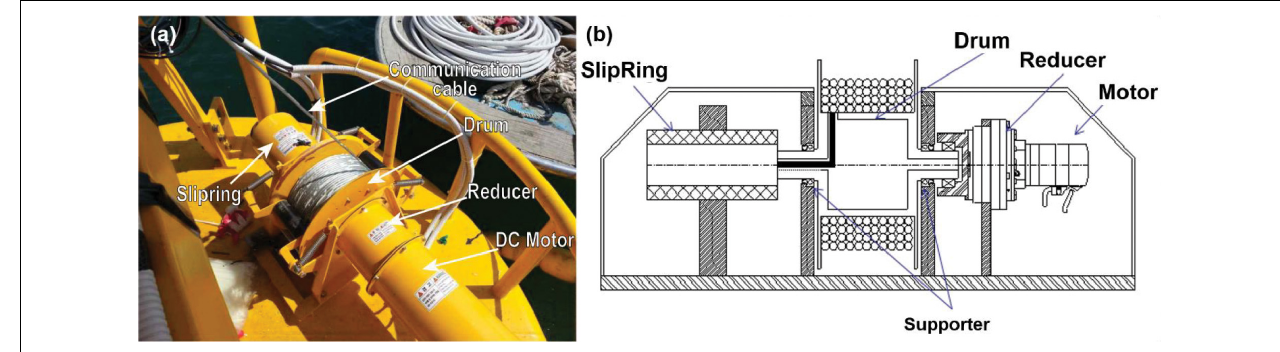
FIGURE 7 | (a) Picture of winch, (b) schematic of winch, which is controlled by the automatic lifting system (ALS).